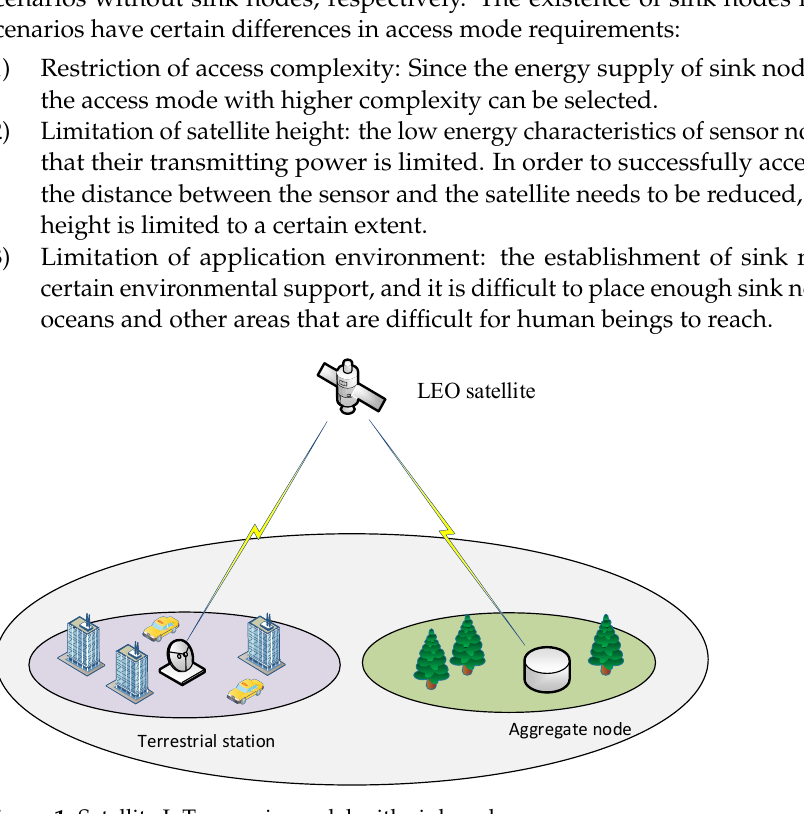
Figure 2. Satellite IoT scenario model without sink nodes. 2.1. Satellite Iot Scenarios without Sink Nodes 2.1.1. ALOHA Protocol In a network containing multiple ‐ user terminals, as long as the user terminal has a packet that needs to be sent, the packet will be sent immediately; if a collision occurs, the user terminal will retransmit the packet after a random retreat for a period of time. Its working principle is shown in Figure 3. The advantage of pure ALOHA protocol is that its implementation is very simple, and it can always support heterogeneous information packets of different lengths, so it is very suitable for satellite IoT, which is a network where terminals work suddenly [16,17]. But the pure ALOHA protocol also has a big problem, that is, its maximum normalized throughput is too low, only 0.184. Its low throughput performance is mainly caused by the generation of “collisions” and new “collisions” caused by packet retransmission. Especially in the case of excessive load, the existence of “collision” almost makes the system unable to work, resulting in the instability of the system [18,19].